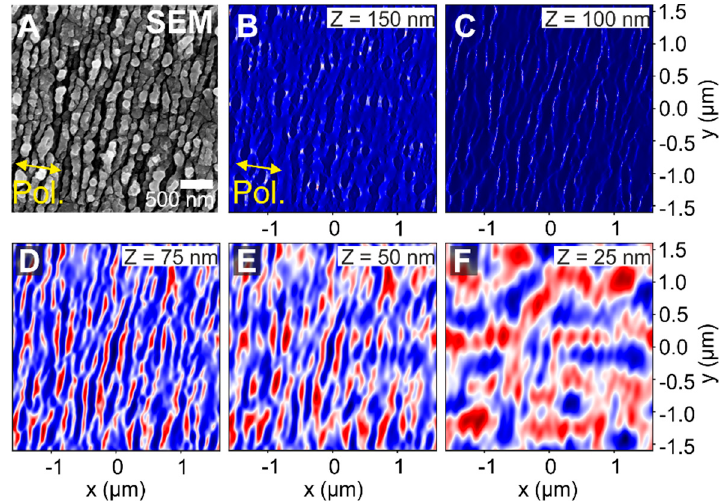
Figure 10. FDTD simulation of a layered system that includes periodic HSFL Λ (cid:2892)(cid:2903)(cid:2890)(cid:2896) = 100 nm given by the real structures shown in the SEM micrograph on the top left ( A ), HSFL modulation depth d HSFL = 75 nm, no added roughness ( 𝑅 (cid:2892)(cid:2903)(cid:2890)(cid:2896) = 0 nm) and oxide layer thickness T ox = 100 nm. The intra oxide film position varies between Z = 150 nm ( B ), Z = 100 nm ( C ), Z = 75 nm ( D ), Z = 50 nm ( E ), and Z = 25 nm ( F ). The laser beam ( λ = 800 nm) polarization direction is horizontal. The colors of the intensity plots are encoded in a false color scheme where red indicated deviations above and blue below the average intensity value of the image, represented in white.